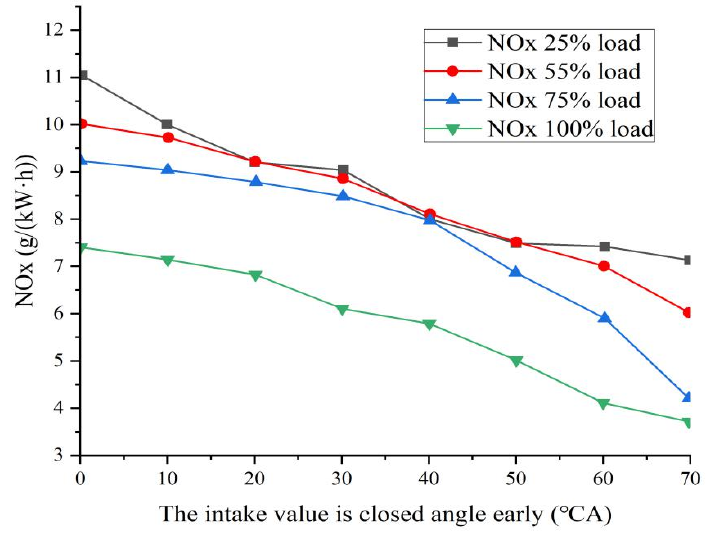
Figure 9. The impact on NO x emission when Miller degree > 0.